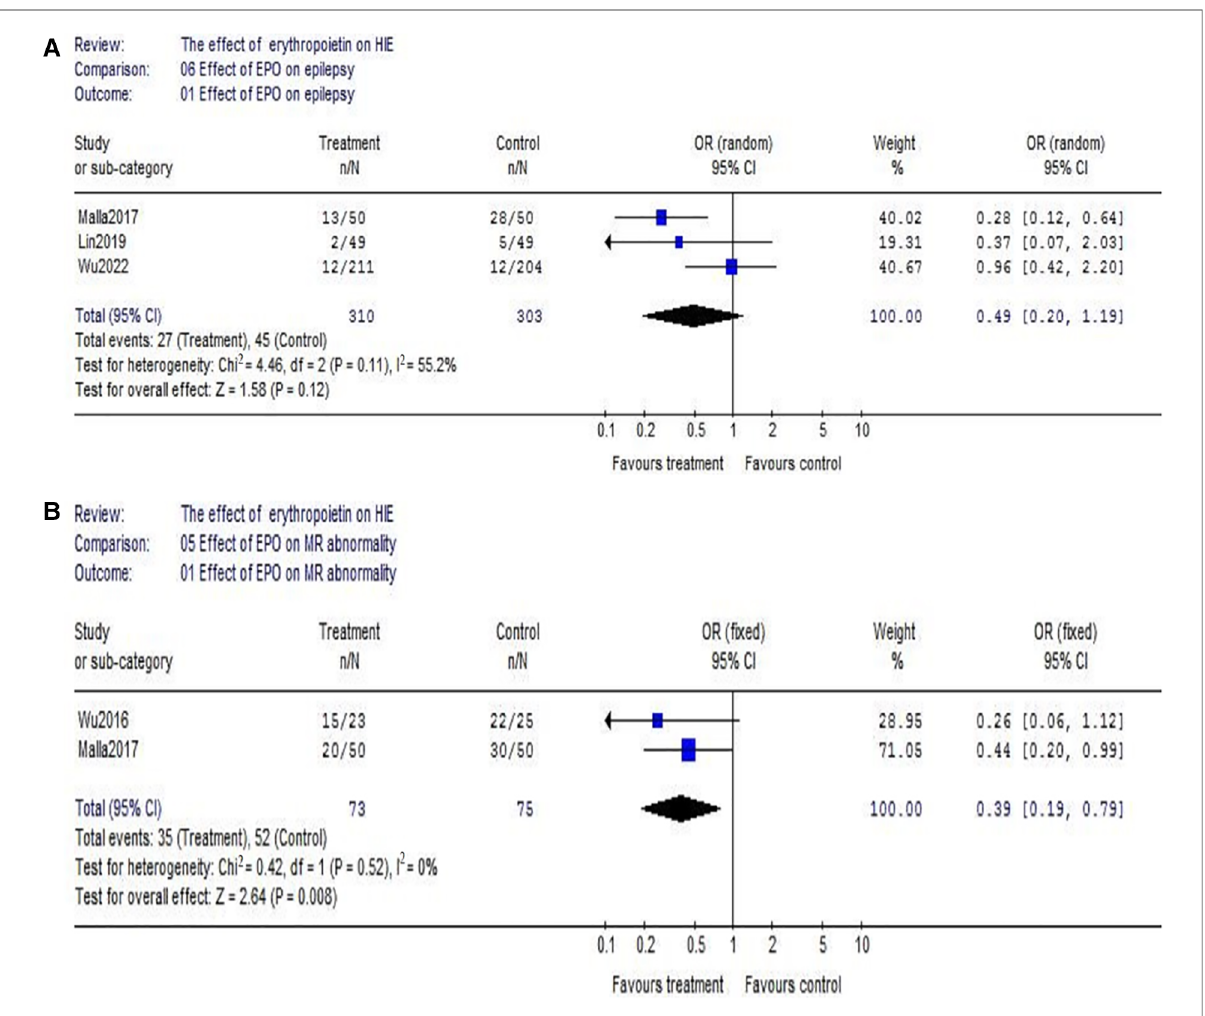
FIGURE 5 The comparison of effectiveness of EPO treatment on epilepsy and MR abnormality. ( A ) Effect of EPO on epilepsy; ( B ) Effect of EPO on MR